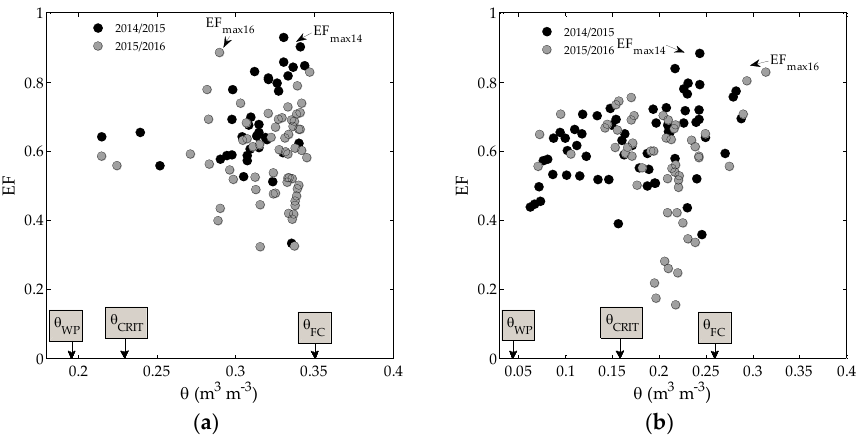
Figure 6. Evaporative fraction, EF, vs. soil water content, θ (m 3 m − 3 ), for ( a ) SMA and ( b ) PAS. Gray rectangles indicate the position of values of θ CRIT (critical soil water content), θ FC (experimentally measured field capacity), and θ WP (permanent wilting point).